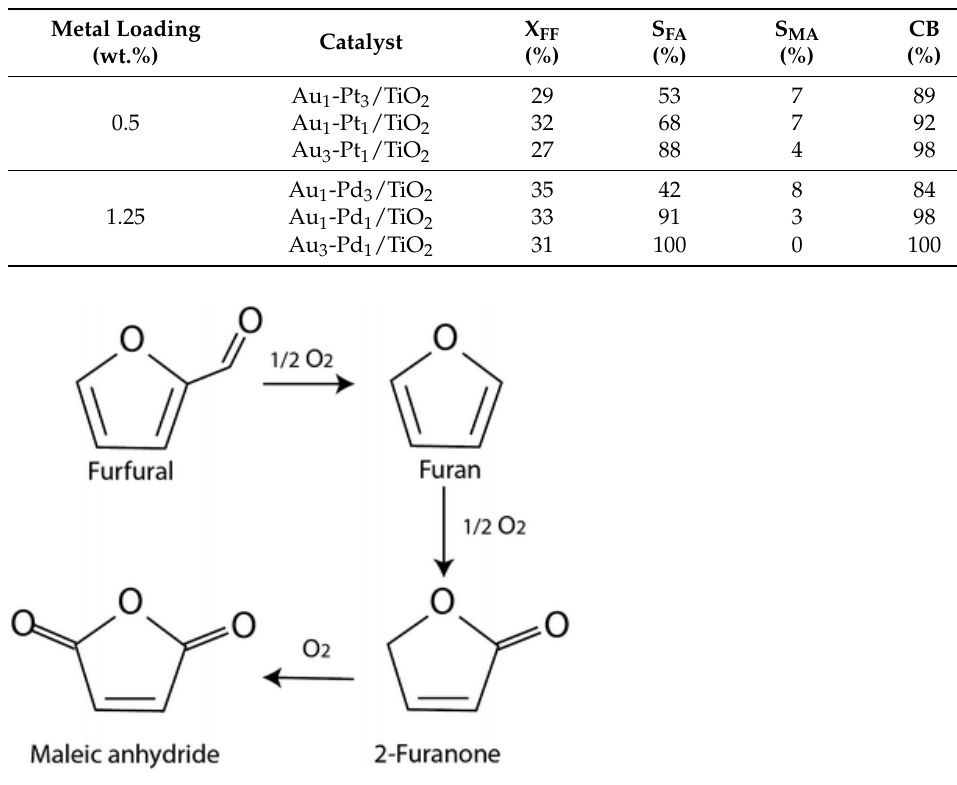
Table 5. Selectivity to FA and MA using 0.5% Au-Pt and 1.25% Au-Pd catalysts (T = 80 ◦ C, t = 4 h, P(air) = 15 bar, 600 rpm).